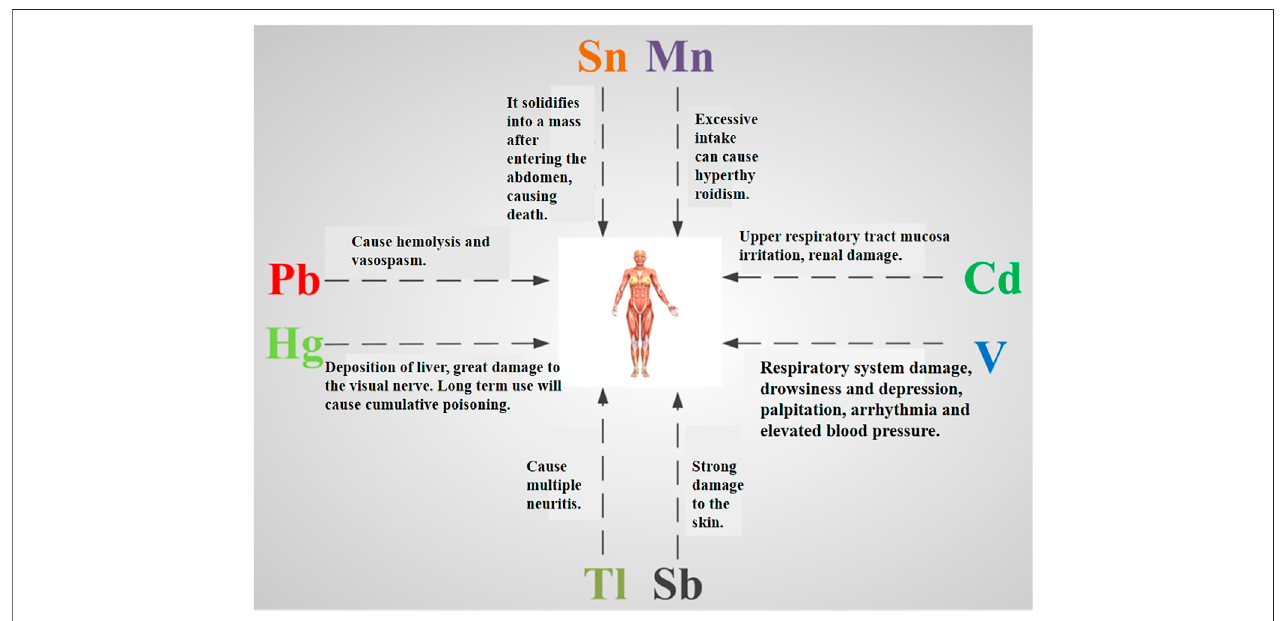
FIGURE 1 | Symptoms of heavy metal